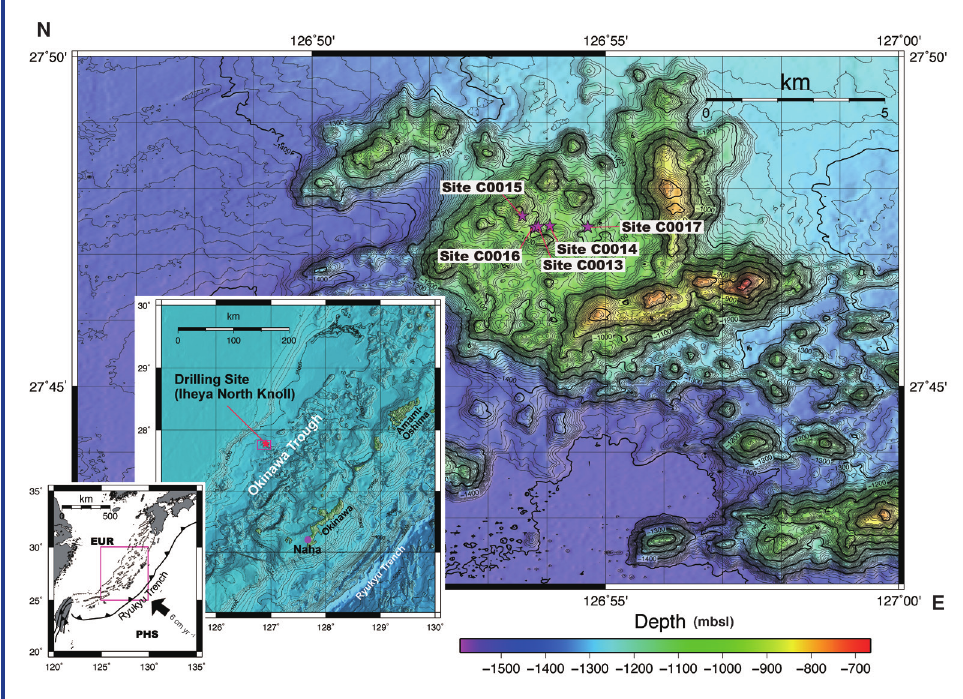
Figure 1. Area map of Iheya North Knoll showing Sites C0013–C0017 drilled during Expedition 331. Insets show the Iheya North Knoll in relation to Okinawa and Okinawa in relation to major tectonic components. EUR= Eurasian Plate, PHS = Philippine Sea Plate. Modified from Takai et al.